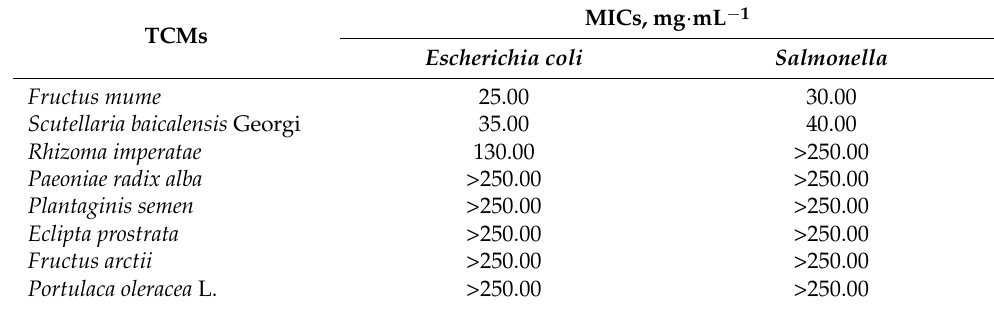
Table 3. The MICs of the water maceration extracts of eight TCMs for Escherichia coli and Salmonella.